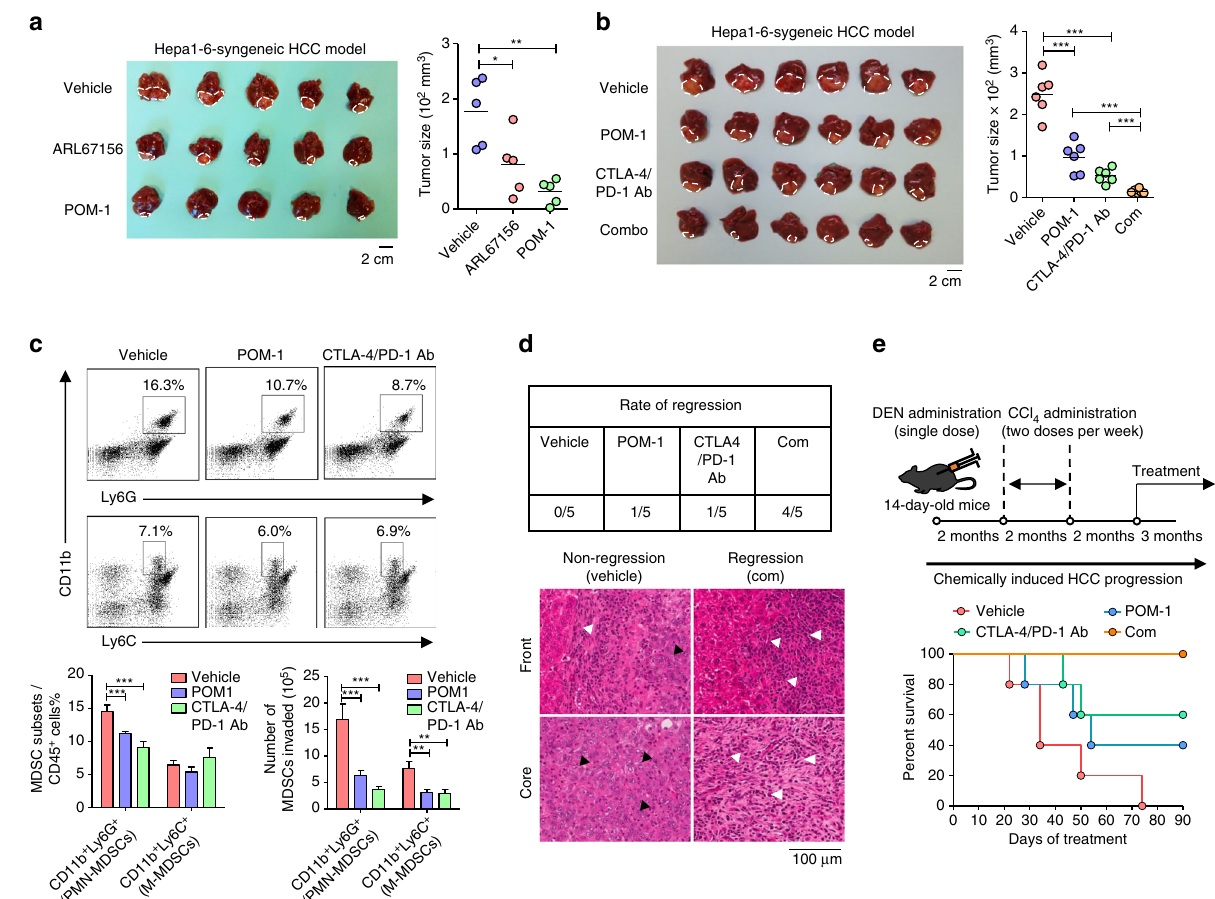
Fig. 6 Combined treatment with ENTPD2 inhibitor and anti-PD-1/anti-CTLA-4 immune checkpoint inhibitors in C57BL/6 HCC-bearing mice. a C57BL/6 mice were orthotopically implanted with 3 × 10 6 Hepa1-6. On day 3, mice were administered with vehicle, 3 mg kg − 1 ARL67156 or 10 mg kg − 1 POM-1 through i.p. injection for 8 consecutive days ( n = 5 for each group). Images of tumors collected from mice and tumor size was measured with caliper. b C57BL/6 mice were orthotopically implanted with 3 × 10 6 Hepa1-6. On day 3, mice were administered with vehicle or 10 mg kg − 1 POM-1 i.p. injection for 8 consecutive days, whereas on day 5 and day 9, mice were administered with 4 mg kg − 1 control IgG antibody or 2 mg kg − 1 anti-PD-1 and anti-CTLA-4 immune checkpoint inhibitors (CTLA-4/PD-1 Ab) through i.p. injection ( n = 6 for each group). Images of tumors collected from mice and tumor size was measured with caliper. c Tumors collected at Day 11 were dissociated and the percentages of CD11b + Ly6C + M-MDSCs and CD11b + Ly6G + PMN-MDSCs in CD45 + cell population and the total number of MDSCs were determined by fl ow cytometry. d Tumors collected at Day 18 were sectioned and stained with hematoxylin and eosin for histological analysis ( n = 5 for each group). The representative pictures of tumor boundaries (front) and tumor cores (core) of vehicle and combined treatment group were shown. Black arrows indicated the tumor cells. White arrows indicated the immune cells. e Survival test of chemically-induced HCC mice. Two-week-old C57BL/6 mice were administered with single dose of 1 mg kg − 1 DEN through i.p. injection (Sigma-Aldrich) and after 8 weeks, with 1.25 ml kg − 1 30% CCl 4 (Sigma-Aldrich) through i.p. injection twice weekly for 8 weeks. Twenty-six-week-old mice were with administered 10 mg kg − 1 POM-1 through i.p. injection thrice weekly or 2 mg kg − 1 PD-1and CTLA-4 monoclonal antibodies through i.p. injection twice weekly ( n = 5 for each group). Data are presented as mean ± s.d. (Student ’ s t -test, * P < 0.05, ** P < 0.01, *** P <